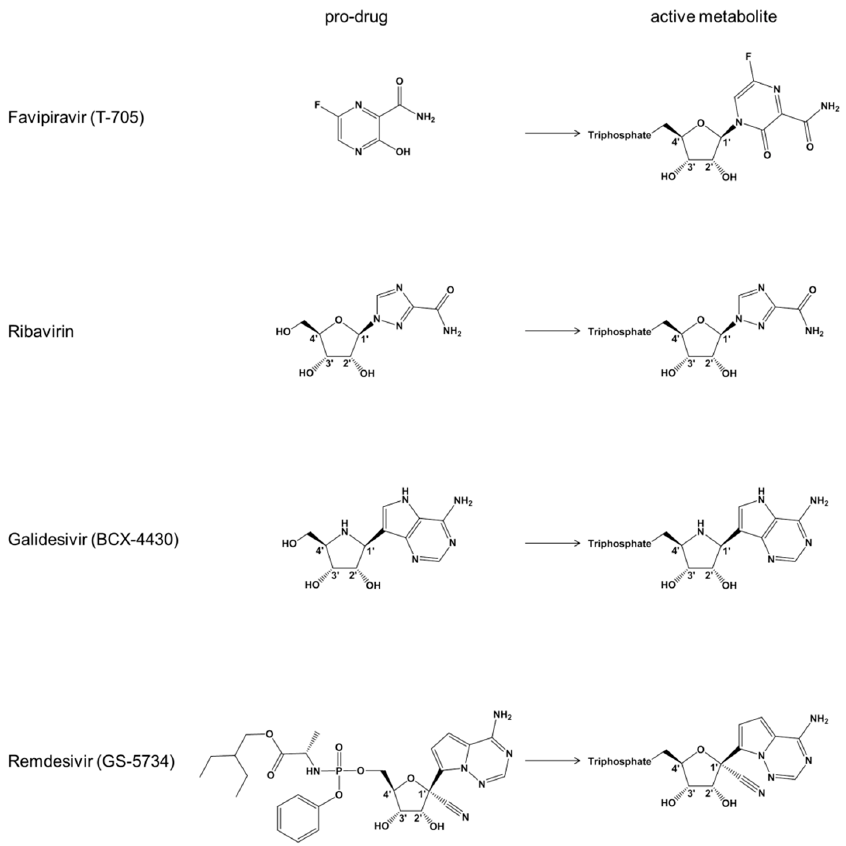
Figure 1. Chemical structures of nucleotide substrate analogues.